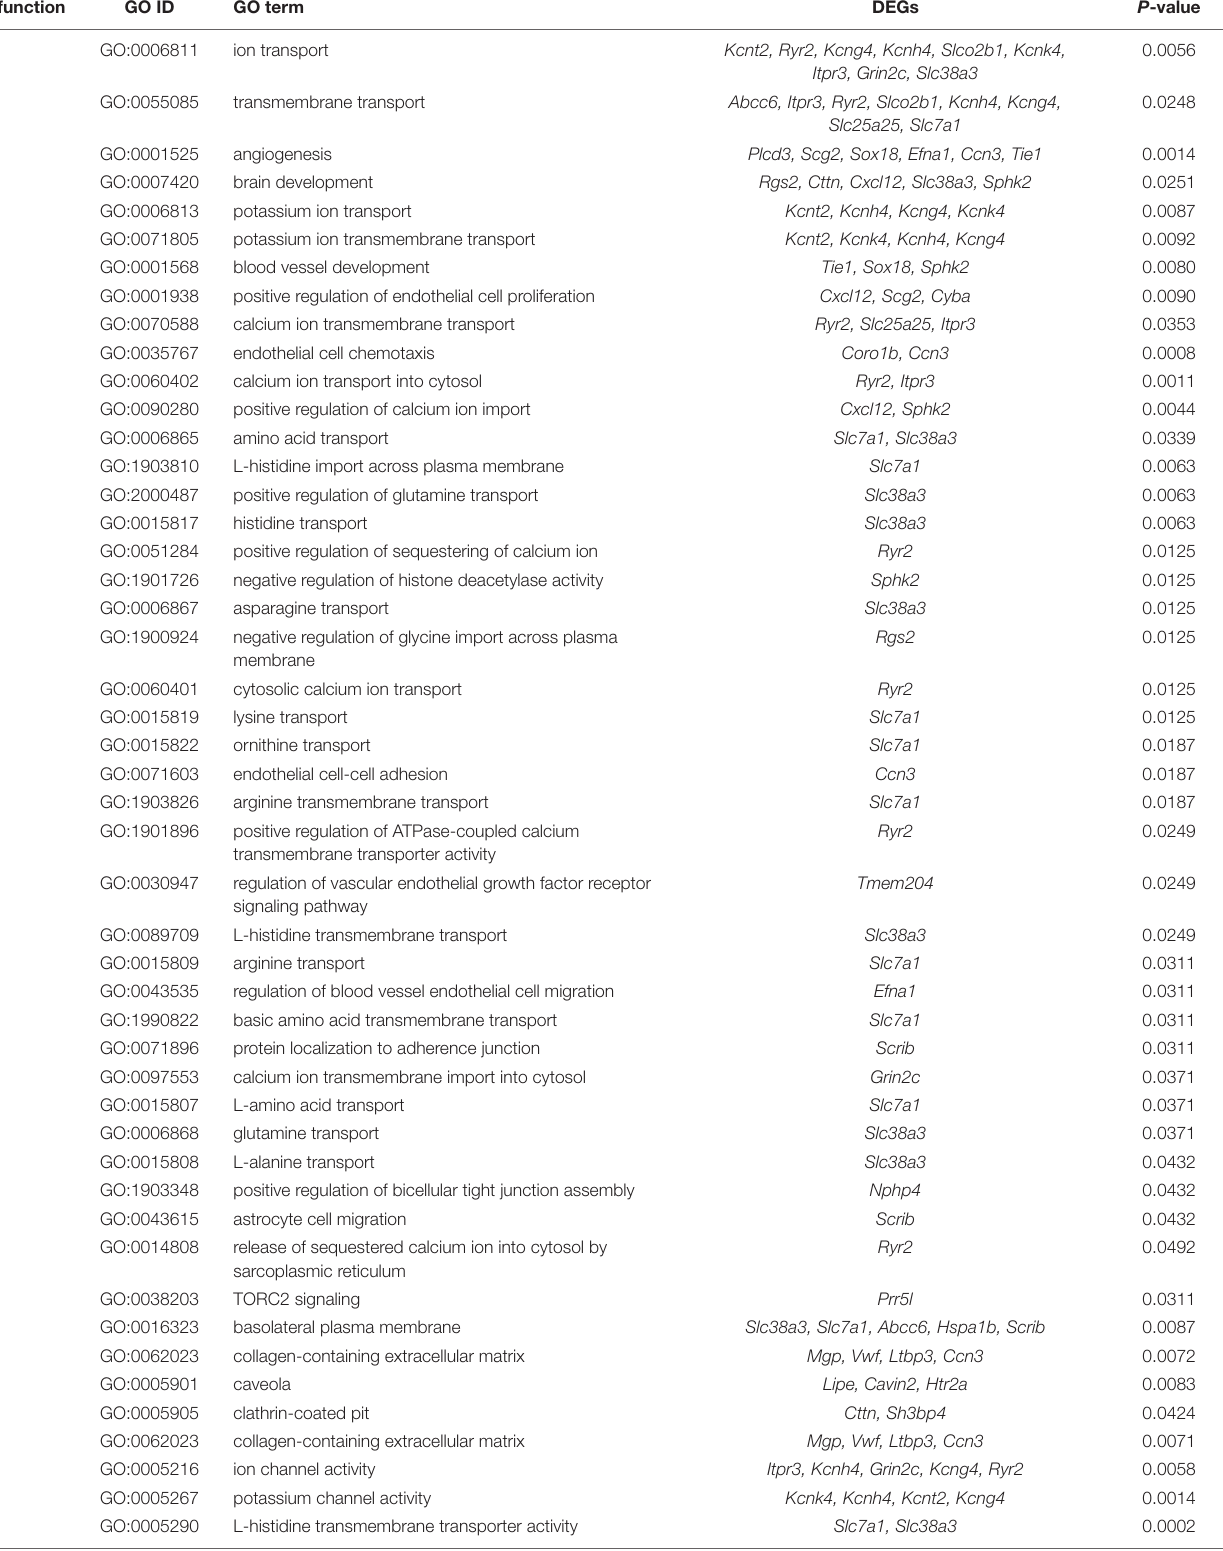
TABLE 4 | Details of all gene ontology terms related to blood-brain